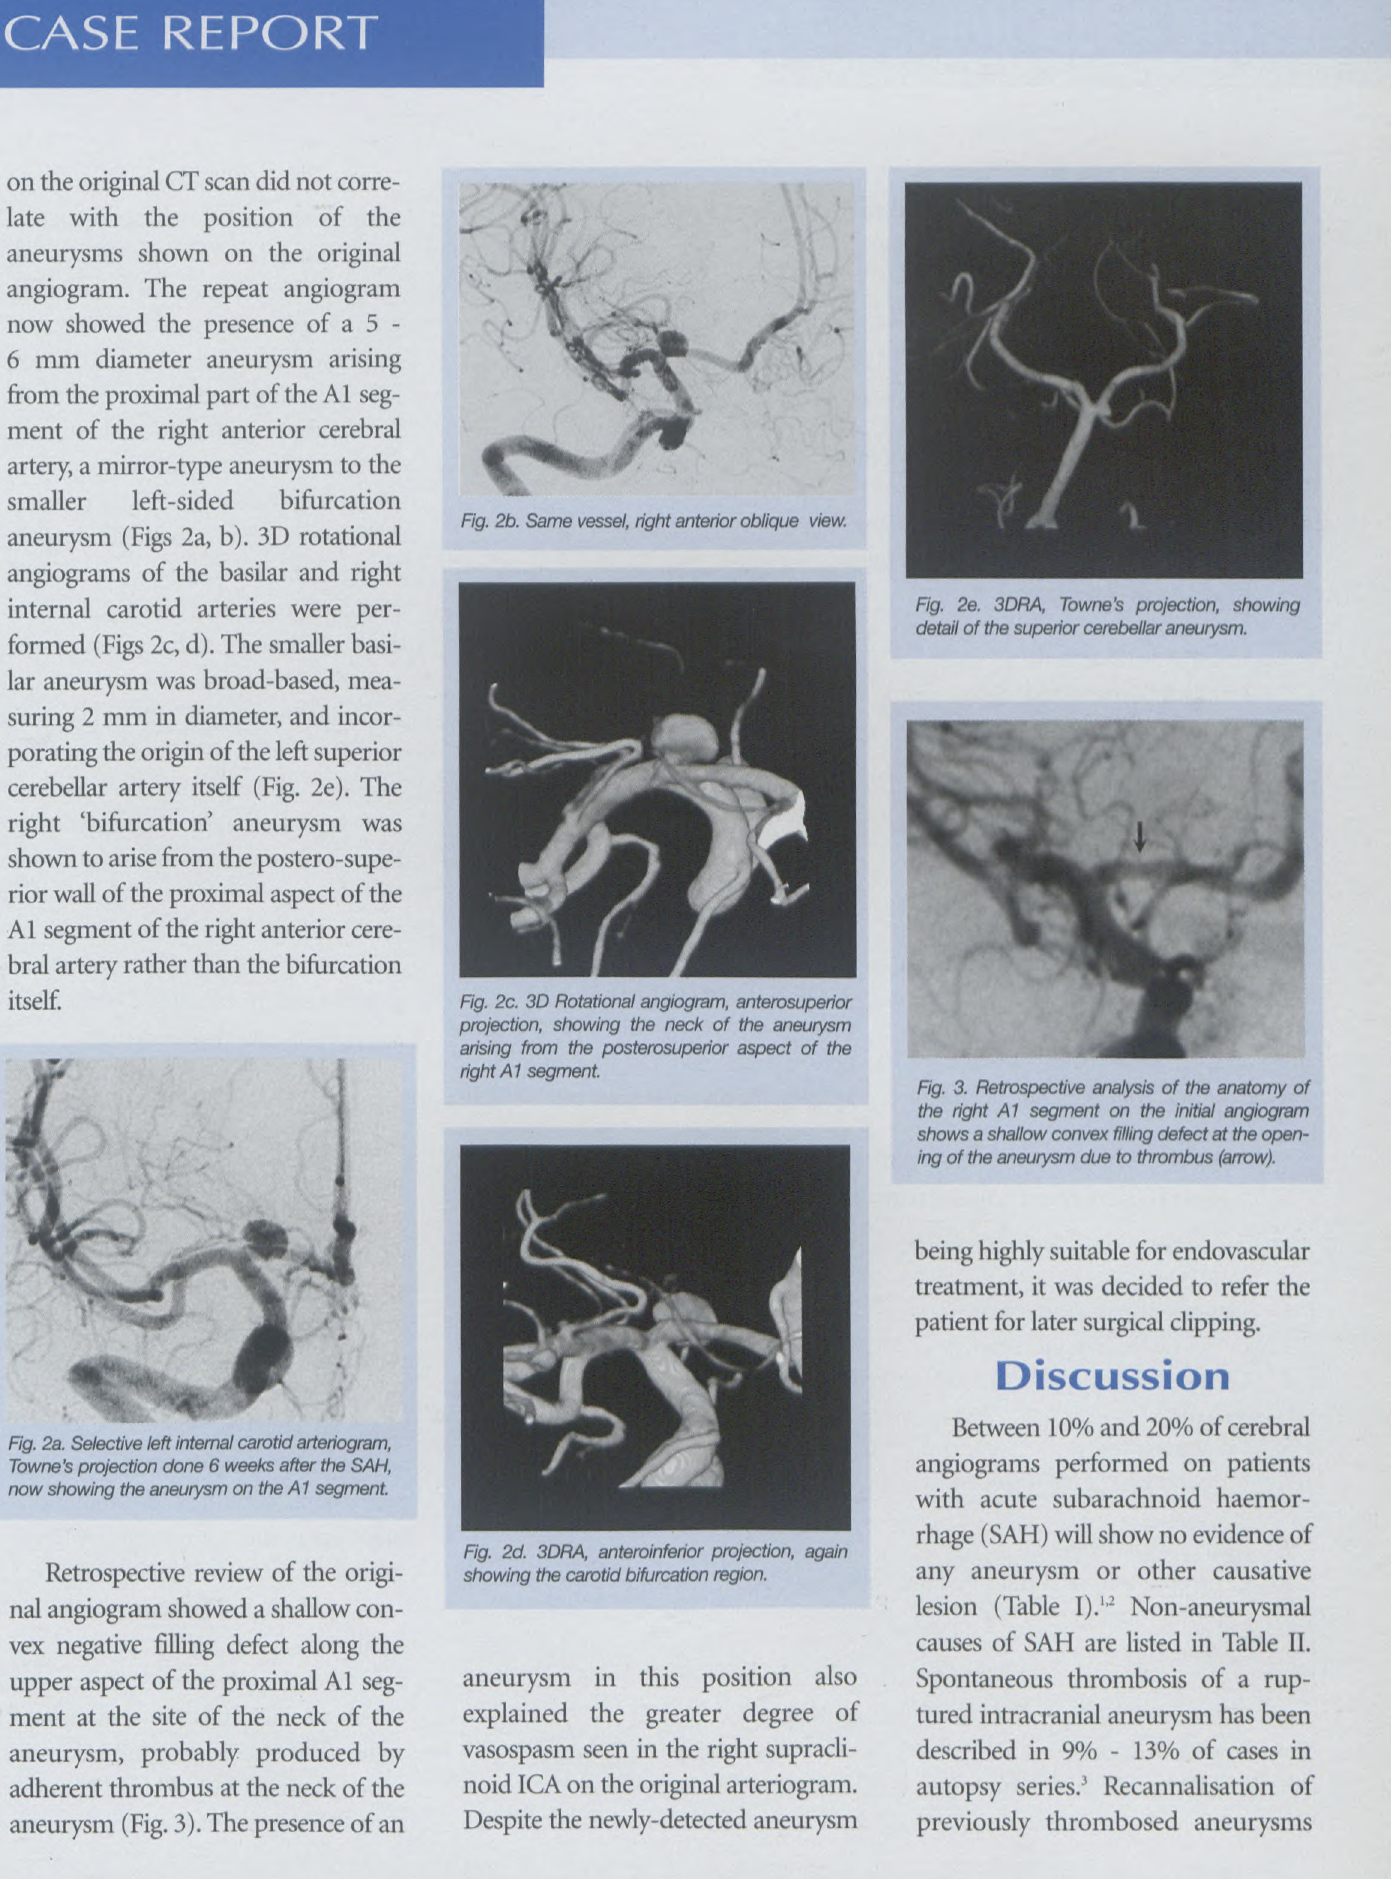
Fig. 2d. 3DRA, anteroinferior projection, again showing the carotid bifurcation region.